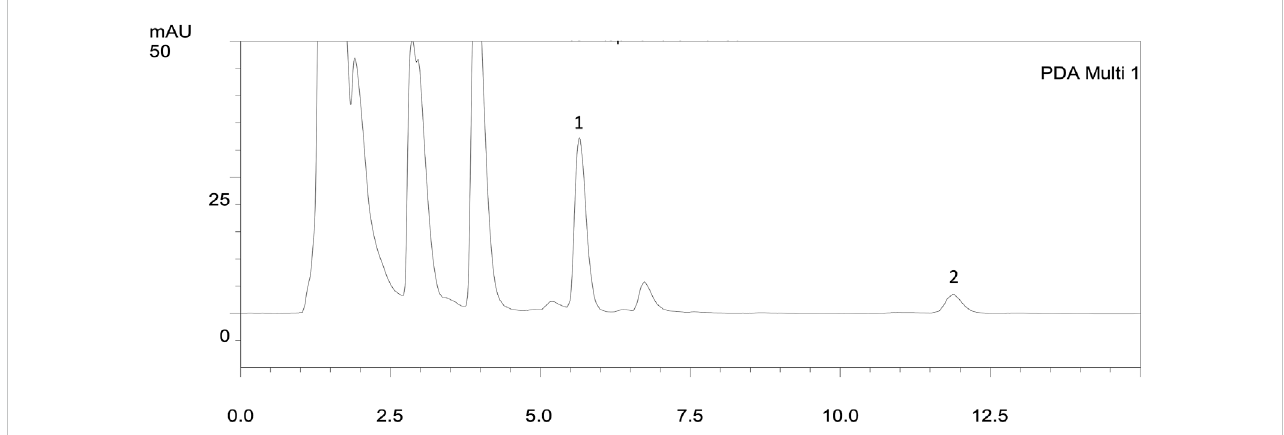
FIGURE 1 HPLCchromatogramsofurineextractsafteradministrationofspironolactonein16 h(20 mg/kg,p.o.).Theparentdrugspironolactonewasnotdetected in the urine extract. 1: n-Propylbenzene (IS, RT: 5.61 min); 2: canrenone (RT: 11.11 min).